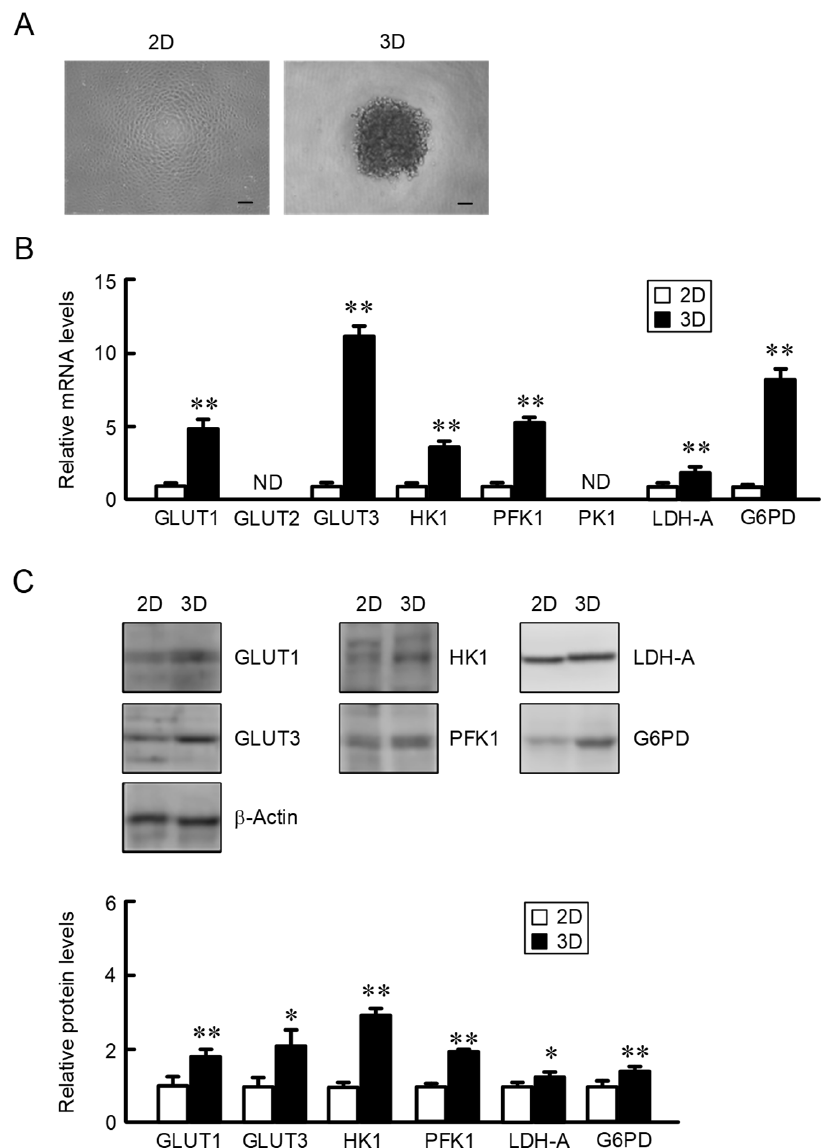
Figure 1. Elevation of glucose transporters and metabolic enzymes by 3D culture. A549 cells were cultured on 6 cm flat dishes (2D) or 96-well round-bottomed plates (3D) for 4 days. ( A ) Representative images of 2D monolayer and 3D spheroid cells. Scale bar indicates 100 µ m. ( B ) Real-time PCR was performed using primer pairs as listed in Table 1. The mRNA levels are represented relative to the values in 2D. ND means under the limit of detection. ( C ) Western blotting was performed using antibodies as listed in Table 2. The protein levels are represented relative to the values in 2D. n = 3–4. ** p < 0.01 and * p < 0.05 compared with 2D.